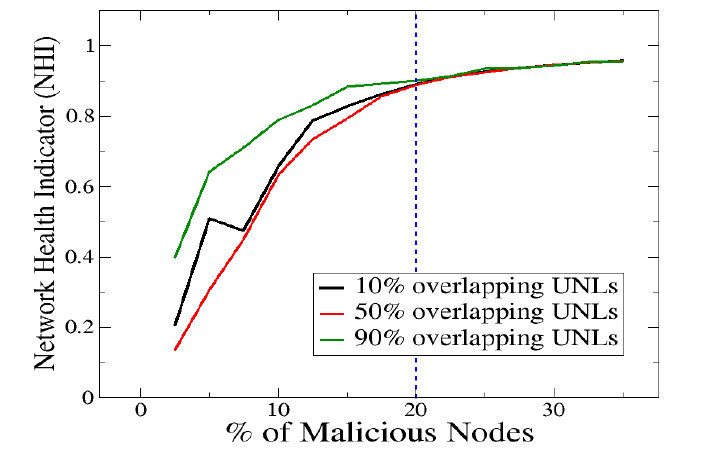
Figure 2. Network Health Indicator (NHI) vs. percentage of malicious nodes for various UNL